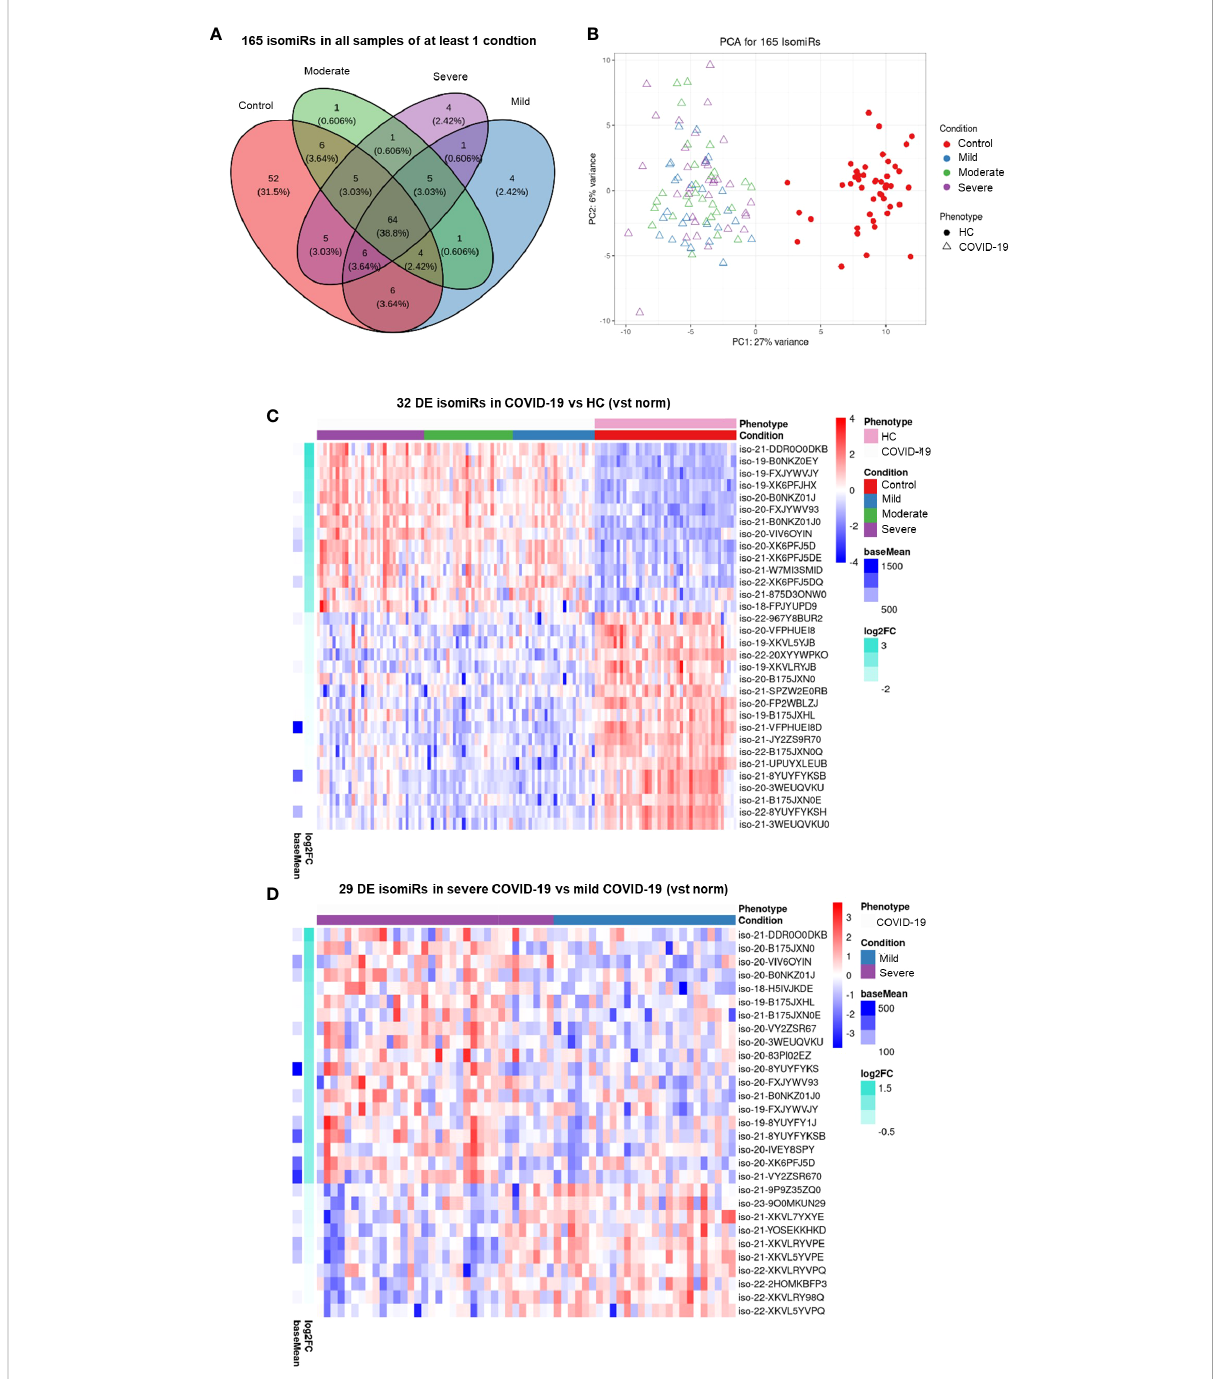
FIGURE 2 Serum isomiR analysis in COVID-19 patients. (A) Venn diagram showing the 165 isomiRs detected by small RNA-seq in serum samples of all individuals belonging to at least one condition. Conditions included healthy control (HC, n = 45), mild COVID-19 (n = 26), moderate COVID-19 (n = 29), and severe COVID-19 (n = 34). (B) Unsupervised principal component analysis of the isomiR expression pro fi les in COVID-19 and HC samples (phenotype); condition is red for HC and blue, green, violet for COVID-19 severity. Heatmaps (C) of the 32 differentially expressed (DE) serum isomiRs between COVID-19 and HC (p-value ≤ 0.01, absolute log2 Fold Change (Log2FC) ≥ 1) and (D) of the 29 DE serum isomiRs between severe and mild COVID-19 (p-value ≤ 0.05, absolute Log2FC ≥ 0.5); standardized expression; the baseMean column on the left indicate the mean expression for each isomiR in all